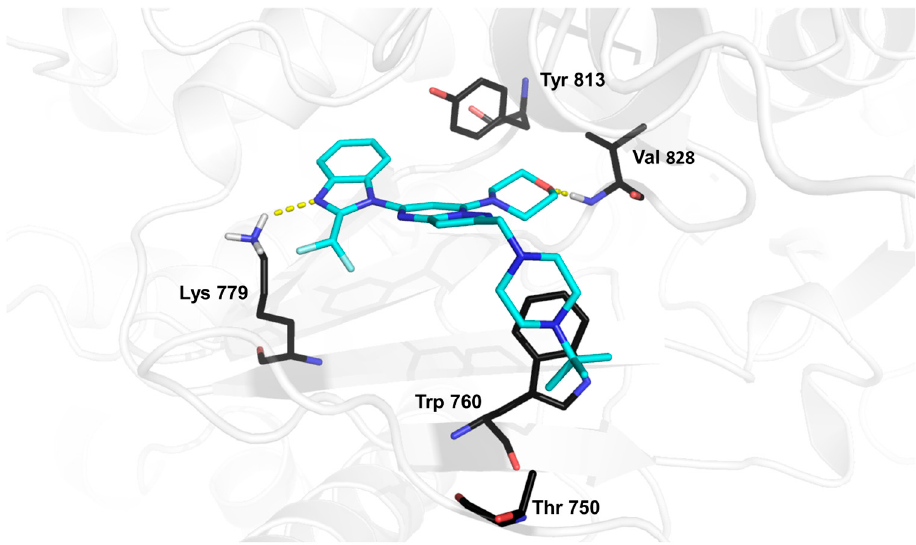
Figure 2. Illustration of the binding mode of CPL302415 ( 2 ) in the catalytic center of PI3K δ obtained by molecular docking [19].